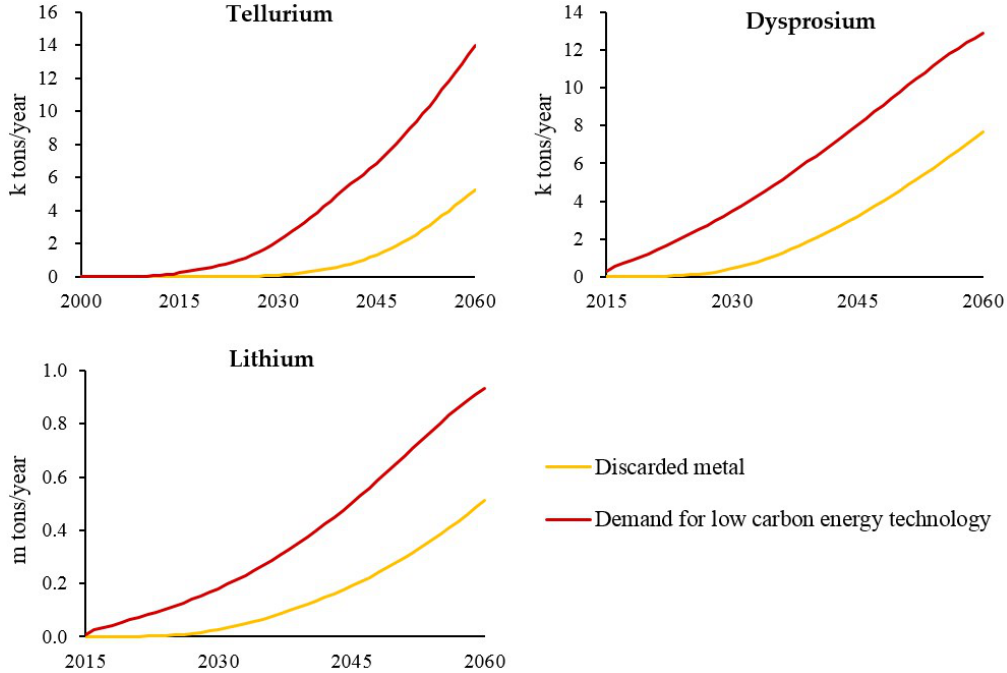
Figure 15. Annual discards of end-of-life material and annual demand for low carbon energy technology. In this case, tellurium discards from CdTe solar panels, Dysprosium discards from wind power using permanent magnets and next-generation vehicles and lithium discards from next-generation vehicles.